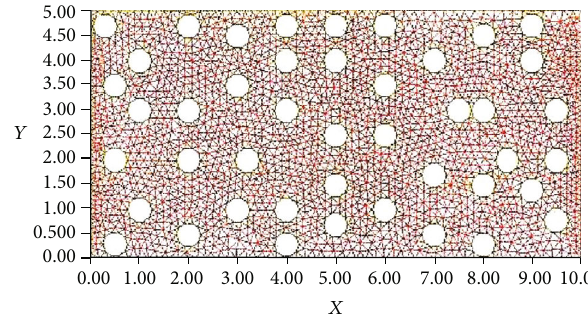
Figure 8: Computational domain for the pollute transport